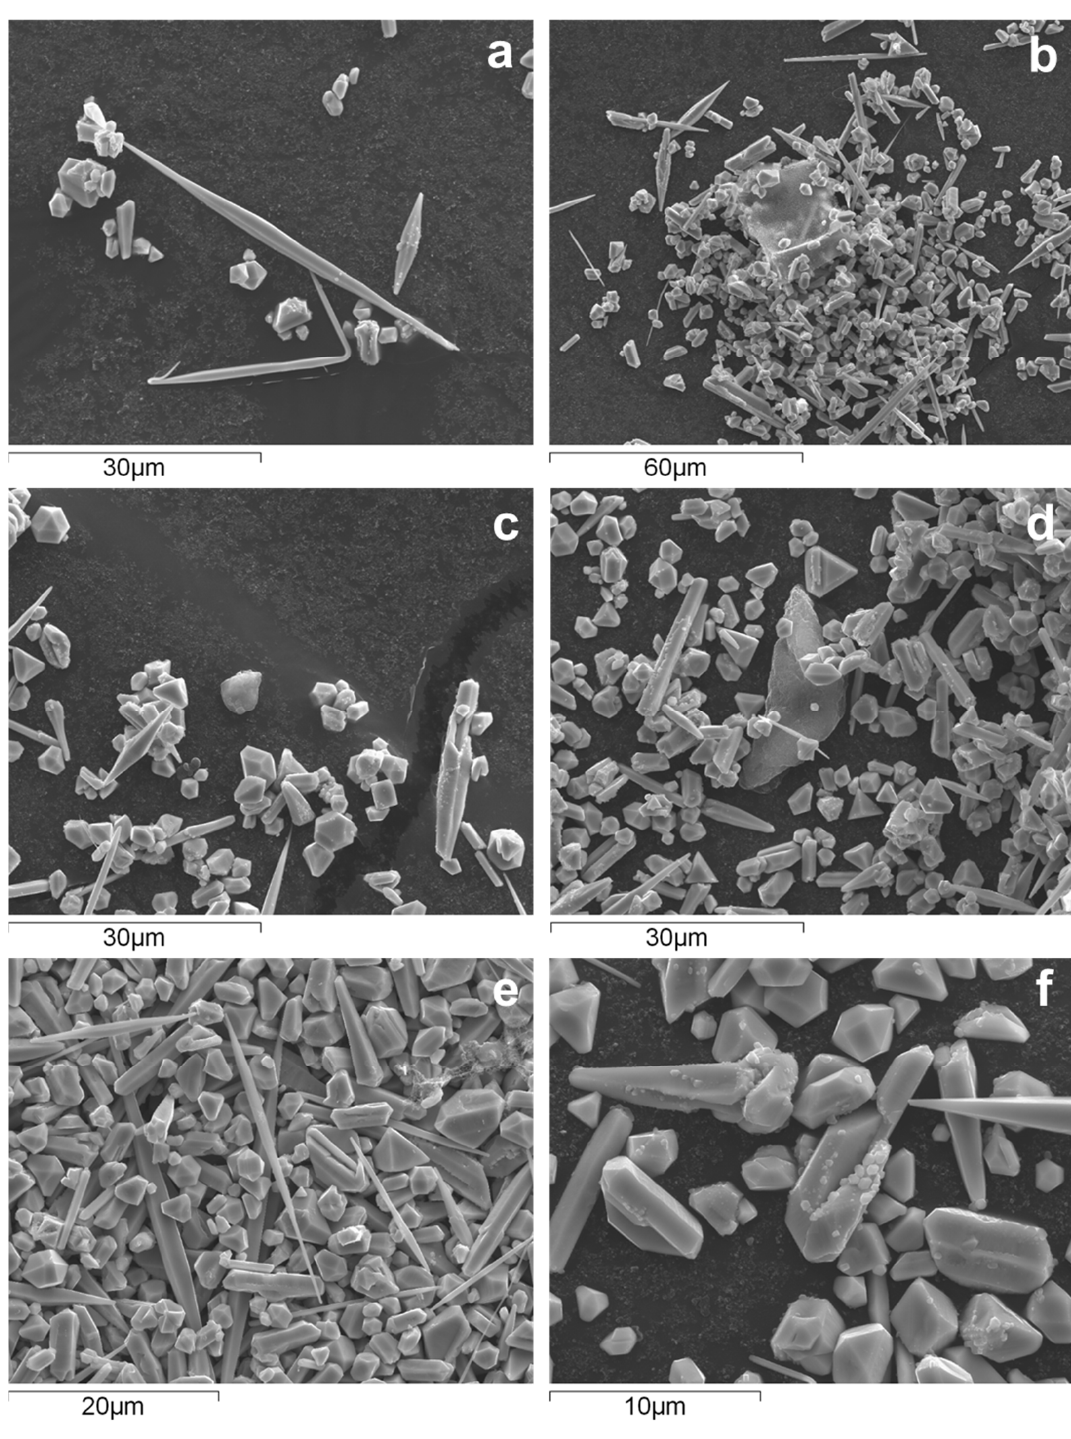
Figure 3. Scanning electron microscopy (SEM) images of the Cu crystals obtained in batch reduction experiments with Cu(II)-rich acidic solutions (pH 3.95, 25 °C) and ascorbic acid 10 mM. Pictures ( a – f ) display different textural and crystallographic features in a single sample (same sample as in Fig- ure 1b,c).